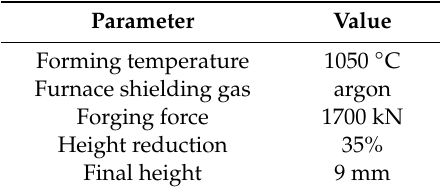
Table 3. Parameters of upsetting process.